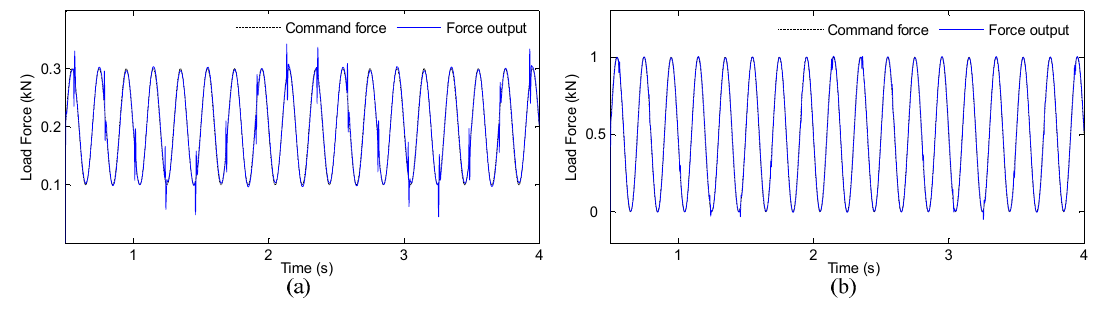
Figure 22. The loading performance of small command loading force, ( a ) command of 200 ` 100sin10 π t (N); ( b ) command of 500 ` 500sin10 π t (N).